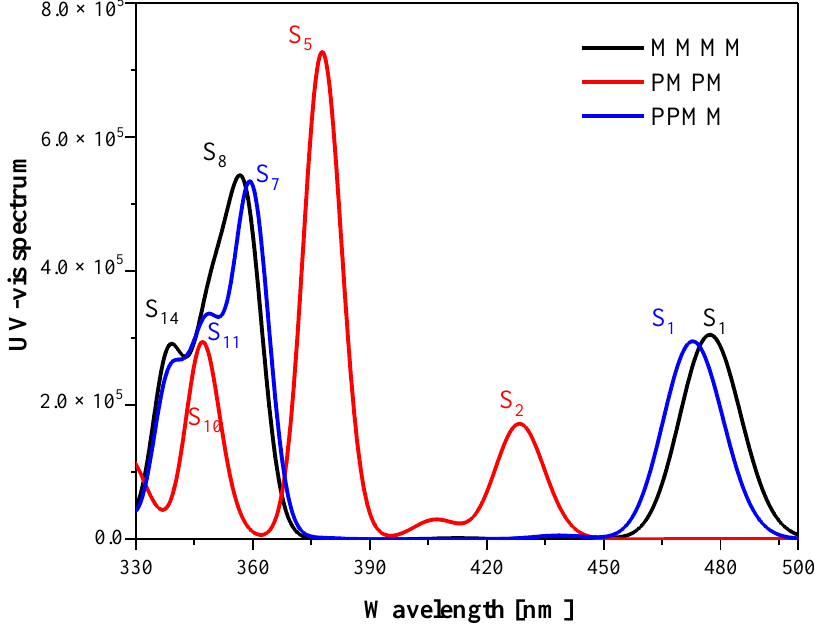
Figure 2. The UV-Vis spectra of three isomeric molecules. The black line represents the UV-Vis spectrum of the asymmetric isomer (The S1, S8, S14 of MMMM), the red line represents the UV-Vis spectrum of the symmetric diastereomer (The S2, S5, S10 of PMPM) and the blue line represents the UV-Vis spectrum of the symmetric diastereomer (The S1, S7, S11 of PPMM).